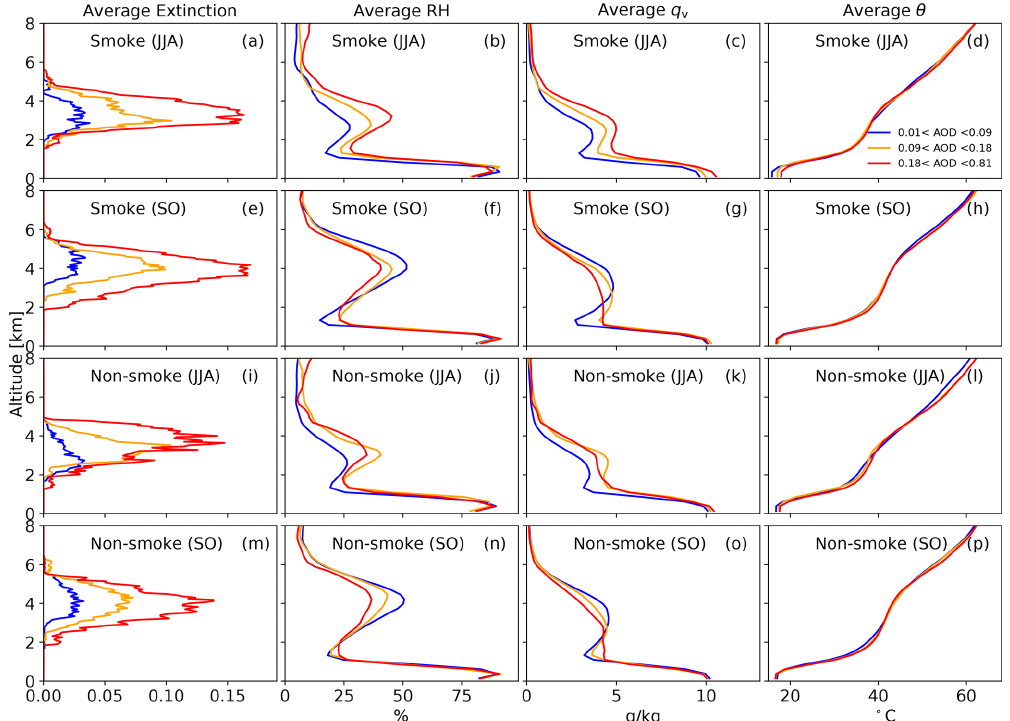
Figure 6. Mean profiles of aerosol extinction, relative humidity (RH), specific humidity ( q v ), and potential temperature ( θ ) for the smoke and non-smoke cases during the months June–July–August (JJA) and September–October (SO). RH, q v , and θ are derived from atmospheric variables in the CloudSat ECMWF-AUX product. Cases are subdivided into three intervals as a function of the aerosol optical depth (AOD) value obtained from the CALIPSO Aerosol Profile Data